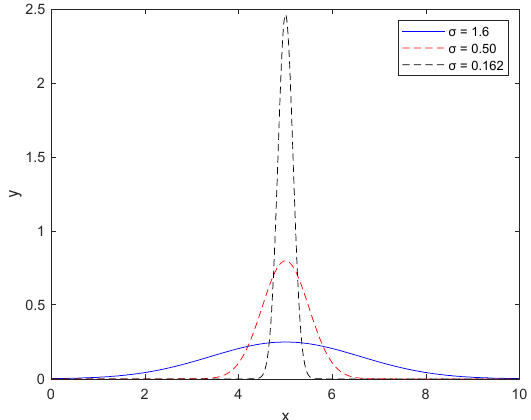
Figure 3. Gaussian distribution function.